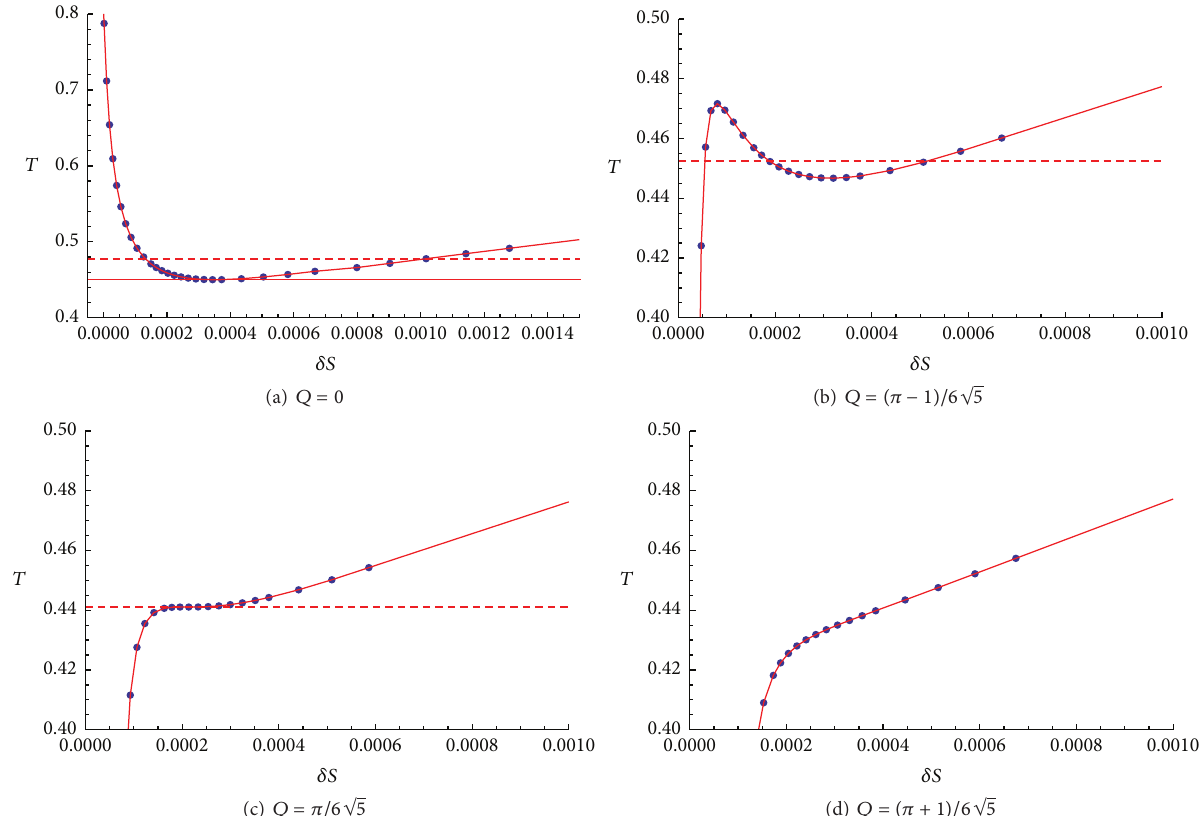
Figure 10: Relation between the entanglement entropy and temperature in the fixed charge ensemble for different charges at 𝜙 0 = 0.2 . The red solid line corresponds to the location of the minimum temperature 𝑇 0 ; the dashed lines in (a), (b), and (c) correspond individually to the locations of Hawking-Page phase transition 𝑇 1 , first-order phase transition 𝑇 ⋆ , and second-order phase transition 𝑇 𝑐 .